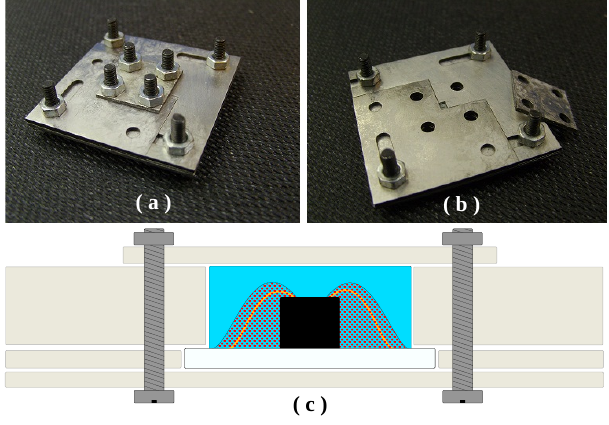
Figure 2. PDMS packaging of the pressure sensor: ( a ) closed mold; ( b ) open mold and ( c ) cross-section of the sensor in the mold during PDMS